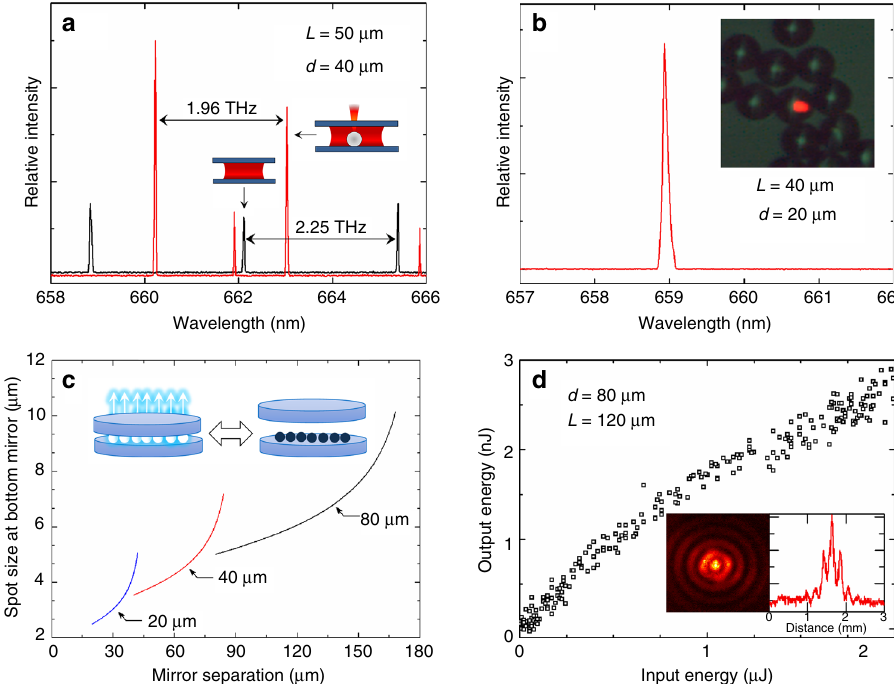
Fig. 4 Summary of the properties of microsphere-stabilized microlaser arrays. a Comparison of the laser spectra recorded for the resonator of Fig. 1a in which a single 40 μ m sphere rests on the lower mirror, with the same resonator but in the absence of a microsphere. b Single-mode spectrum observed for a d = 20 μ m microsphere when L = 40 μ m. The inset is a microphotograph of one lasing sphere in the midst of other spheres. c Stability diagram for d = 20,40,80 μ m diameter spheres showing the variation with L of the laser spot size at the lower mirror. d Dependence of the output pulse energy on the 532 nm optical pump pulse energy for a single 80 μ m diameter sphere. The inset is the laser intensity map for the single optical oscillator in the far- fi eld, along with its intensity